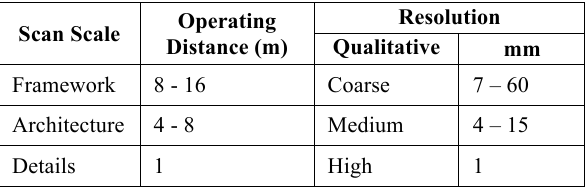
Table 1. Laser Scanner